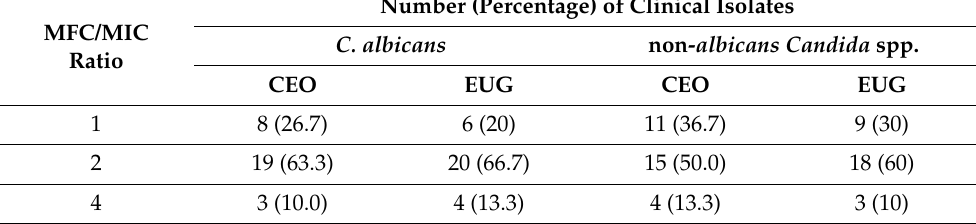
Table 4. The fungicidal effect of CEO and EUG expressed as a MFC/MIC (minimal fungicidal concen- tration/minimal inhibitory concentration) ratio against clinical isolates of C. albicans (30 isolates) and non- albicans Candida spp. (30 isolates) from hospitalized patients with hematological malignancies. Number (Percentage) of Clinical Isolates non- albicans Candida spp.